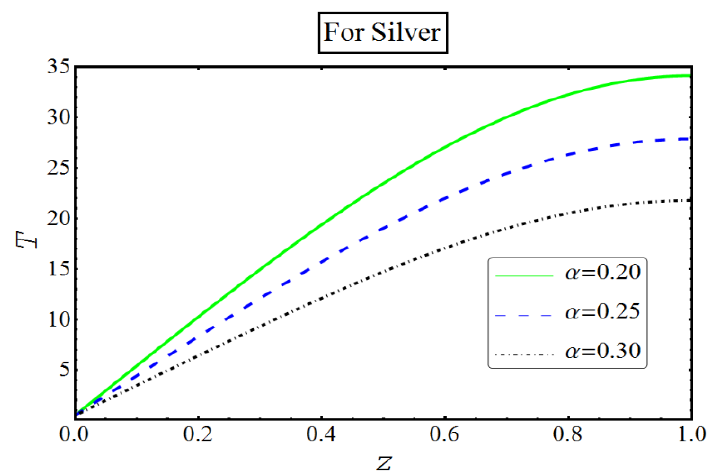
Figure 20. Temperature effects of thermocapillary parameter.